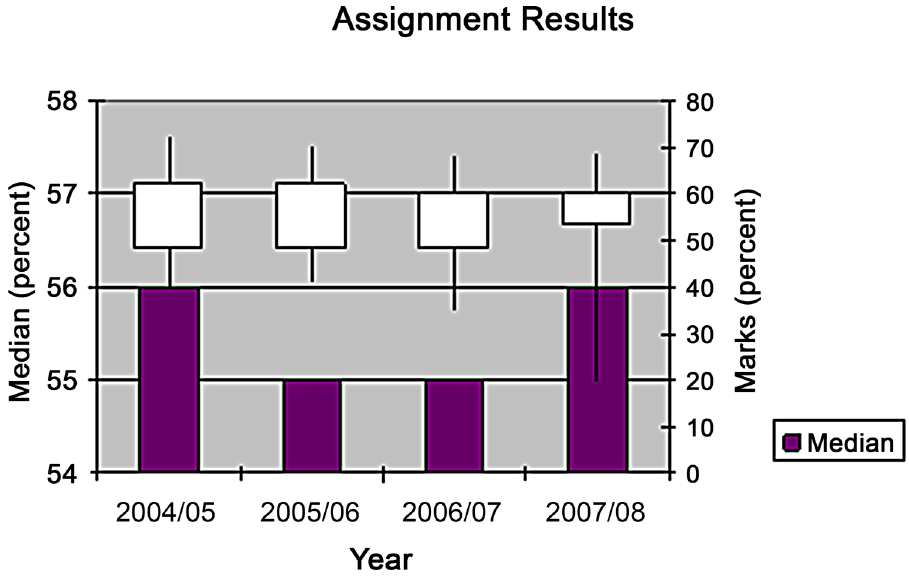
Figure 9. Comparison of median, upper and lower quartile assignment scores